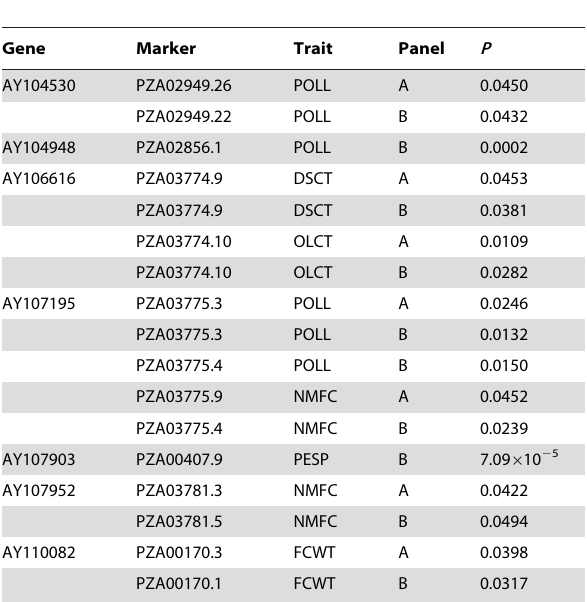
Table 2. Associations that were repeated or survived multiple